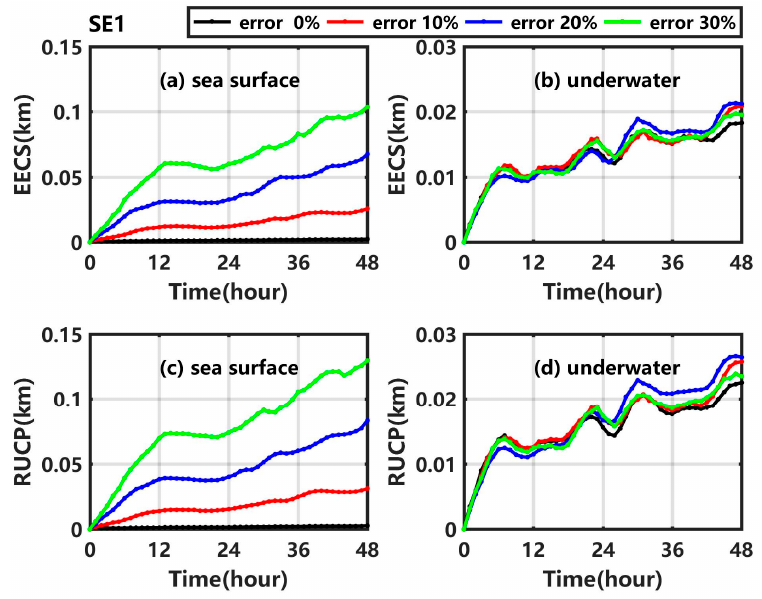
Figure 4. ( a ) EECS at the sea surface, ( b ) underwater EECS, ( c ) RUCP at the sea surface and ( d ) underwater RUCP in Exp1 (black line), SE1_1 (red line), SE1_2 (blue line), and SE1_3 (green line).